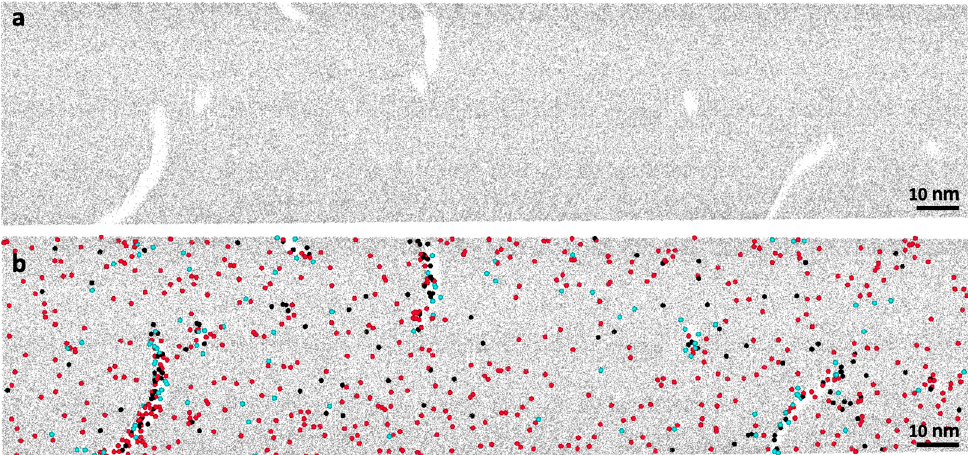
Figure 7. A 0.6 nm thick slice, from the sample aged 4 h at 600 °C. ( a ) All detected ions of Fe (grey). ( b ) All detected ions of Fe (grey), Mo (red), V (turquoise), and C (black) are shown. To increase visibility, the atoms of Mo, V, and C are drawn larger than the Fe atoms.